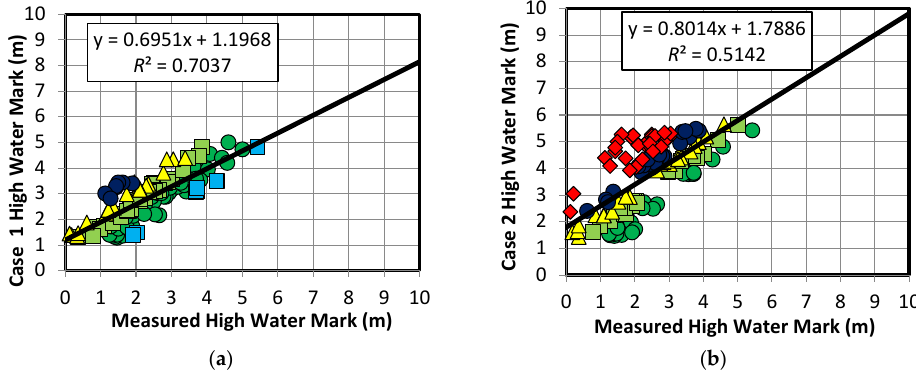
Figure 7. Scatter plots of Rita HWM’s. Red, yellow, and light green points indicate over-prediction by the model; blue, dark blue and purple points indicate underprediction. Green points indicate a match within 0.5 m. The black line represents the best fit lines. ( a ) Case 1; ( b ) Case 2. Table 3. Rita Simulations HWM Error Statistics.